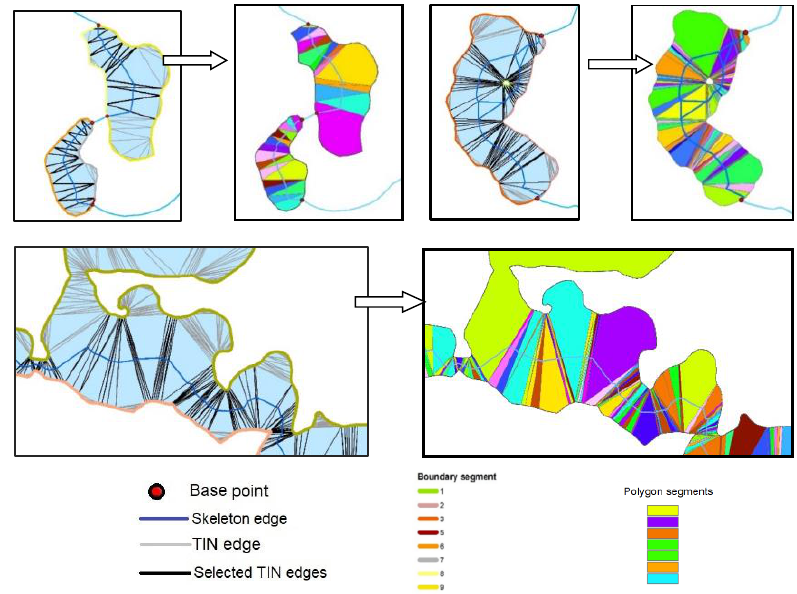
Figure 18. Examples of different polygon segments for generating a skeleton based on the midpoints of the selected TIN edges. A few segments have the shape of type 1 and 3 triangles from Figure 8.